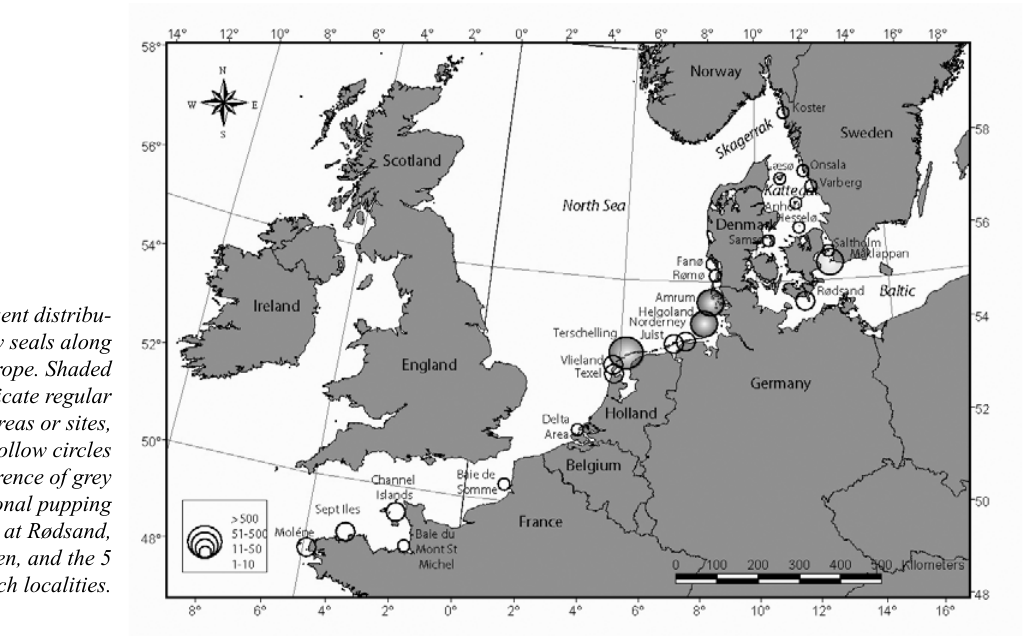
Fig.1 . Present distribu - tion of grey seals along mainland Europe. Shaded circles indicate regular pupping areas or sites, while hollow circles denote occurrence of grey seals. Occasional pupping also occurs at Rødsand, Måkläppen, and the 5 French